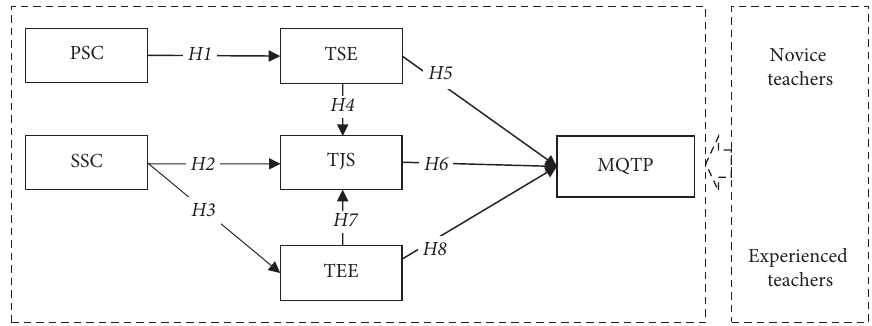
Figure 1: The proposed model. PSC, peer support climate; SSC, supervisory support climate; TSE, teacher self-efficacy; TJS, teacher job satisfaction; TEE, teacher emotional exhaustion; MQTP, motivation to quit the teaching profession. Table 1: Demographic characteristics of the participants ( N � 446).